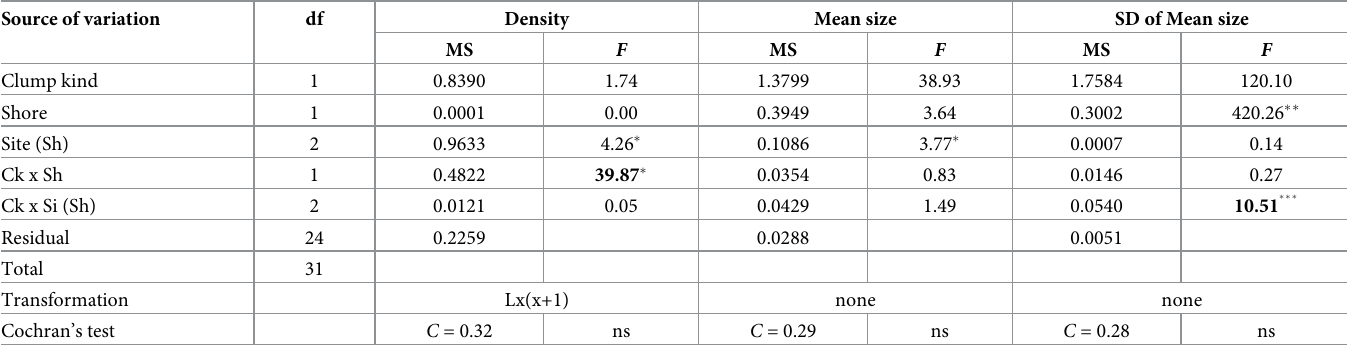
Table 1. Summary of ANOVAs testing differences on density, mean size and standard deviation of mean size of Mytilus galloprovincialis between clump kinds. Source of variation